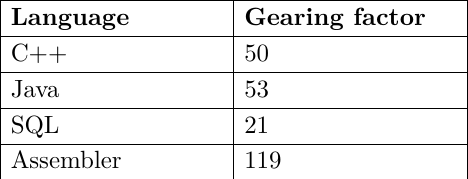
Table 1. Gearing factors of a few different programming